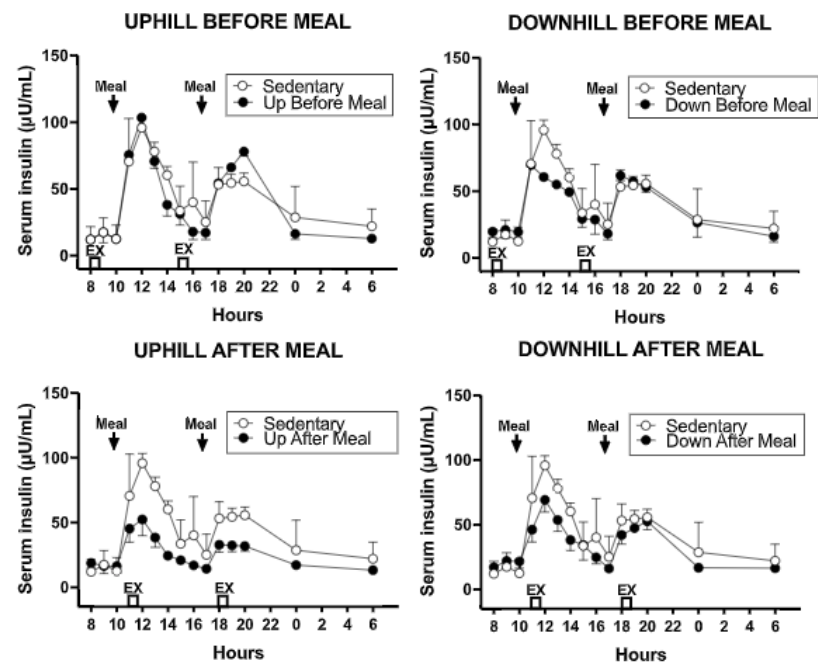
Figure 8. The changes in serum insulin concentration in the four exercise relative to sedentary trials. largest insulin decline occurred in the UAM trial relative to sedentary and exercise-before-meal